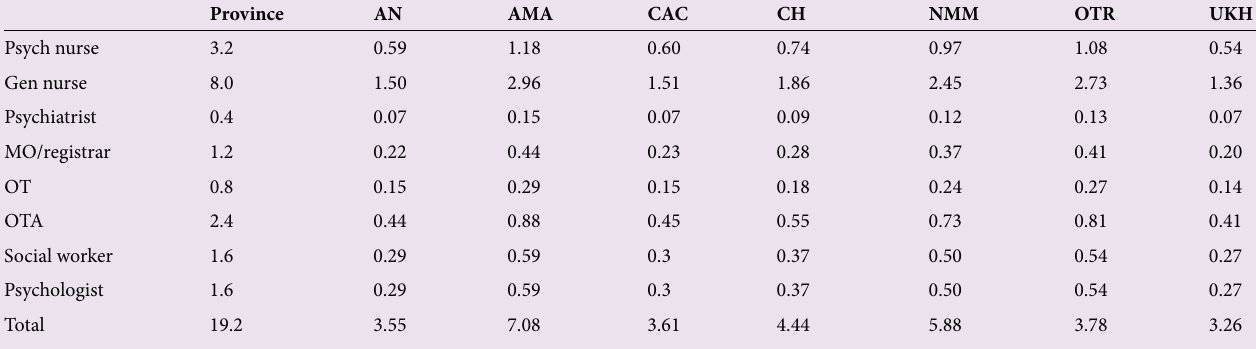
Table 7. Staff requirements per 100 000 population for an ambulatory service